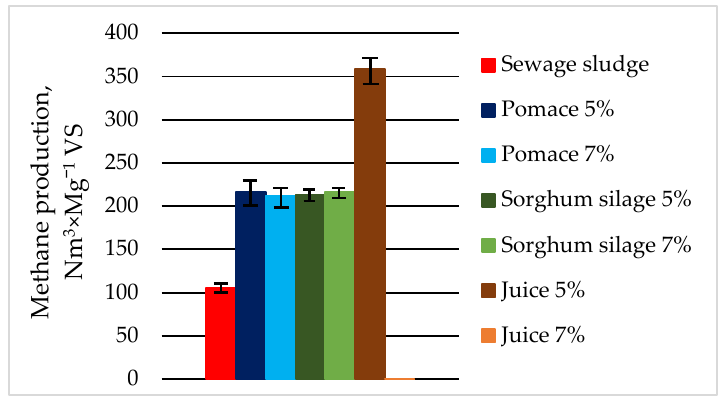
Figure 4. Methane production from sewage sludge and substrates from sorghum.